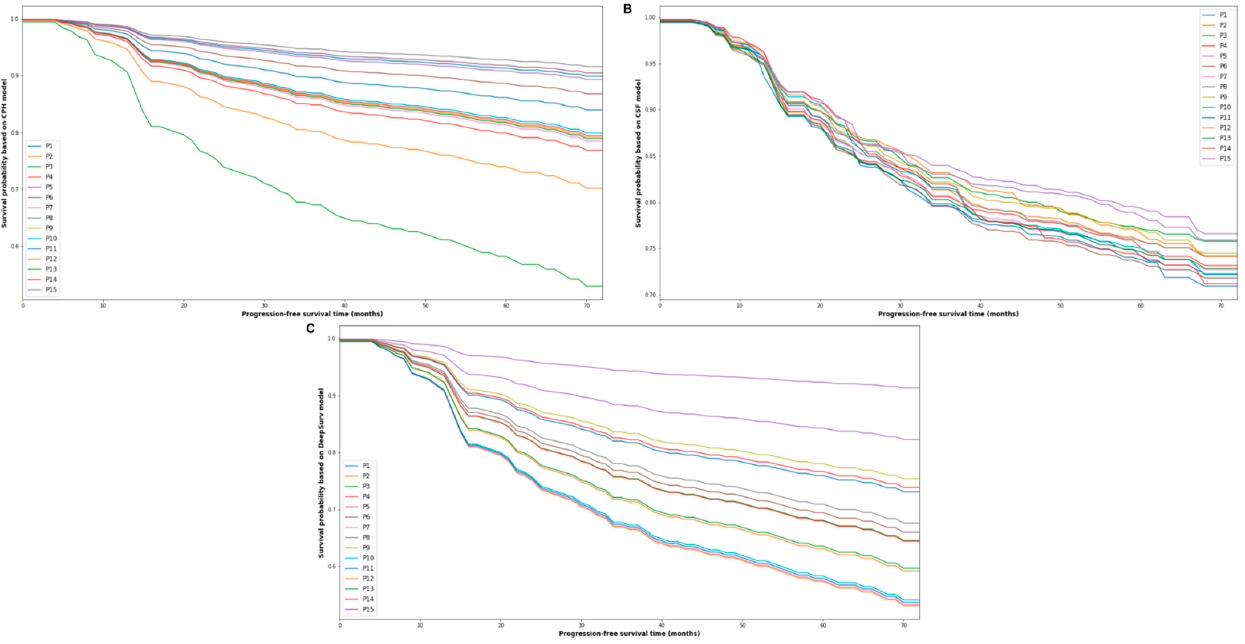
Figure 4. The progress-free survival predictions for 15 patients in the testing cohort based on the three models (( A ) Cox proportional hazards model, ( B ) conditional survival forest, ( C ): DeepSurv).